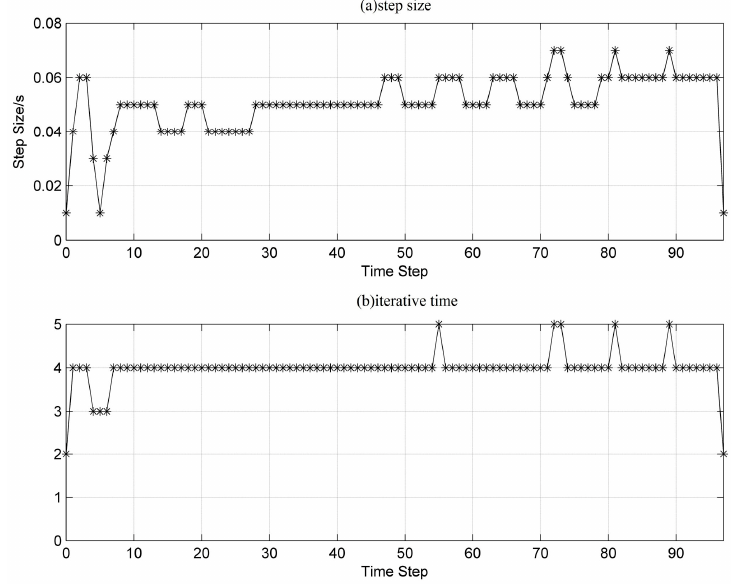
Figure 13. The variation in the step size and iteration times using VSVII in case C.